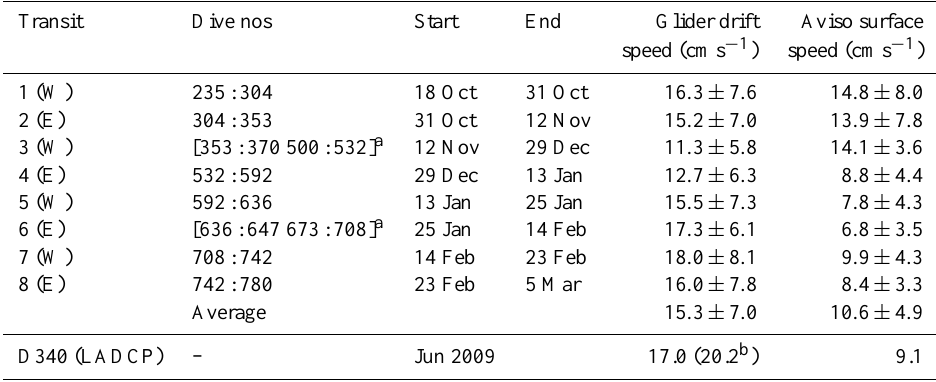
Table 1. Summary of the dives used in most of the calculations and transit plots described below and (bottom row) equivalent speeds from the Ellett Line section during D340. Drift and standard deviation speeds are the scalar mean values per transit. (W) and (E) indicate the direction of travel.